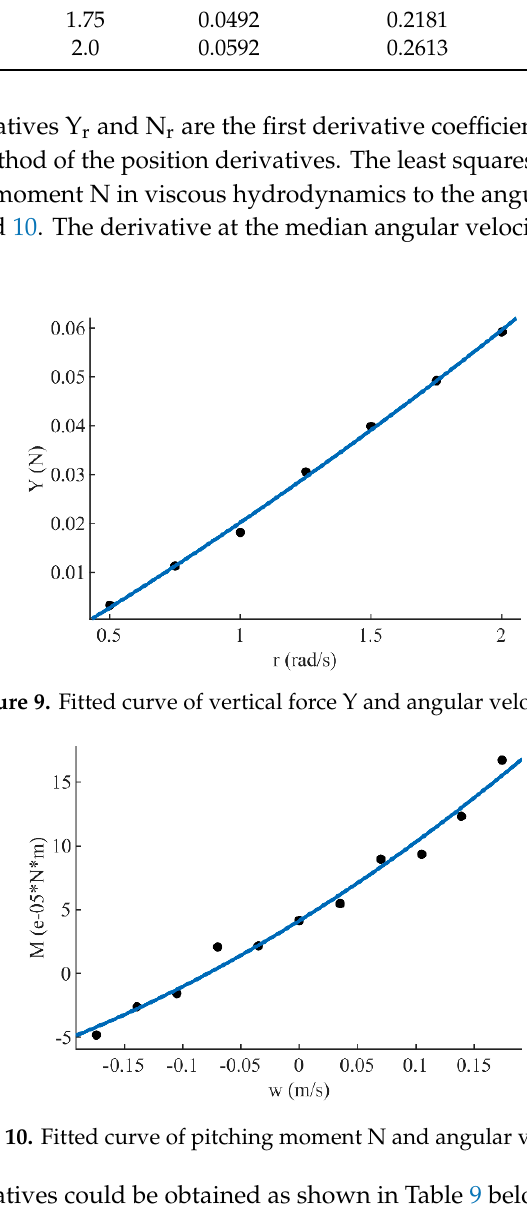
Table 9. Rotation derivatives of the manipulator in viscous hydrodynamics.